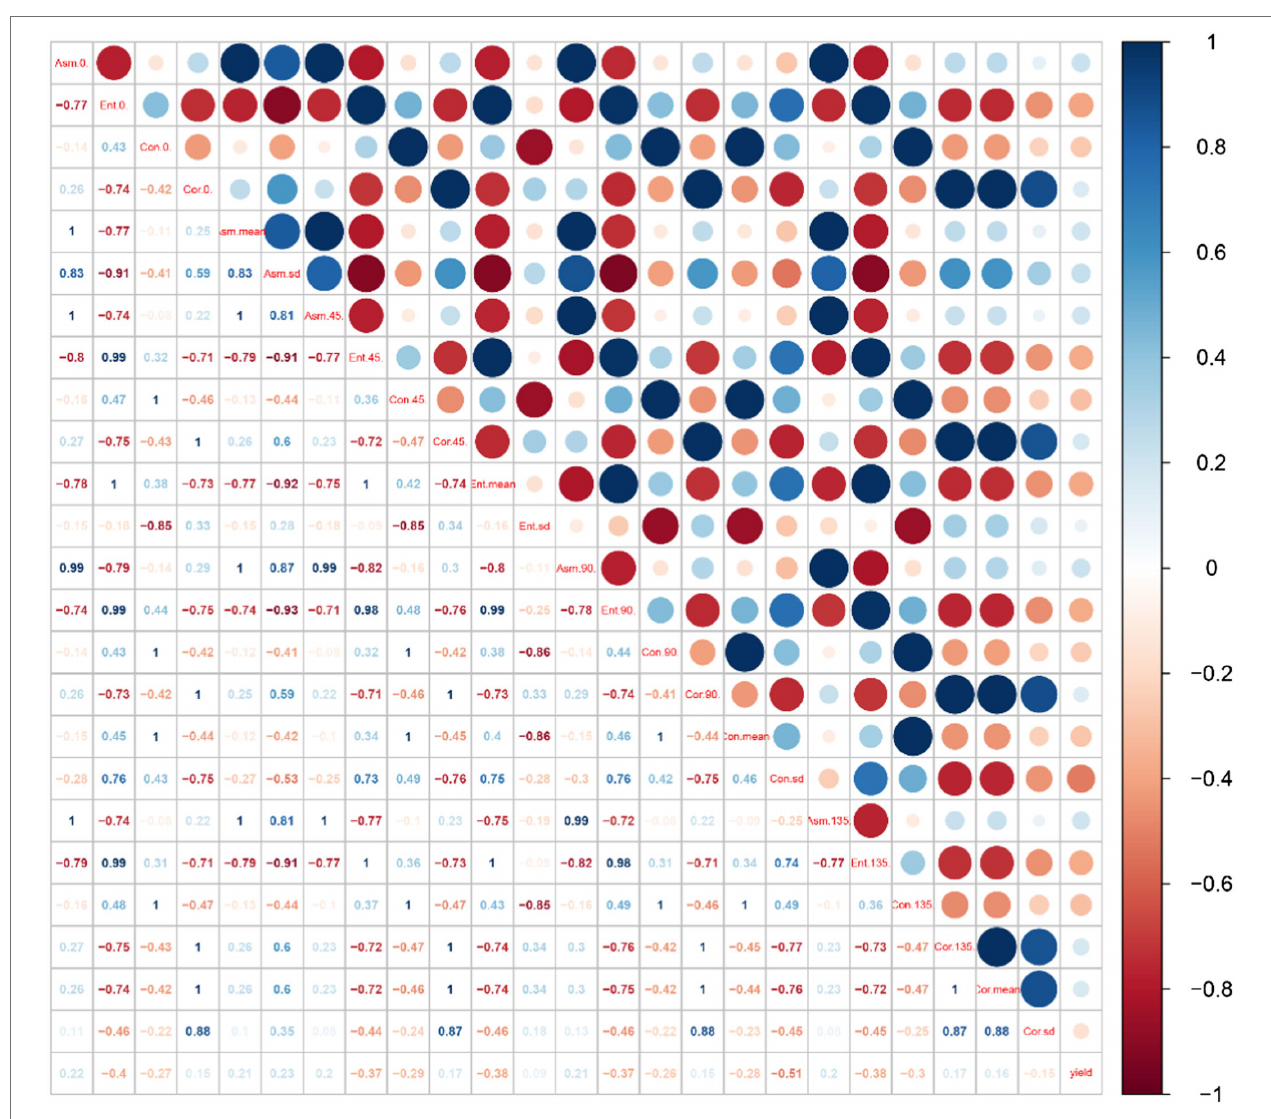
FIGURE 4 | Correlation between different texture characteristics and cotton